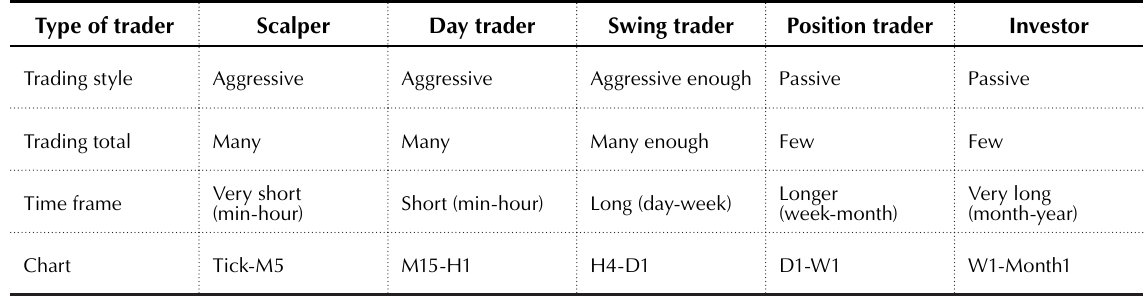
Table 1. Type of